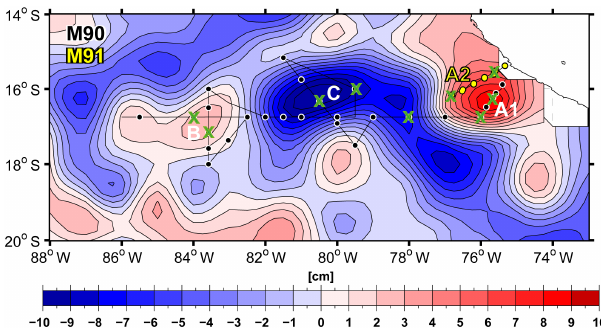
Figure 1. Distribution of AVISO satellite-derived sea surface height anomaly (SSHA) distribution as described by Stramma et al. (2013) on 21 November 2012. Eddies are labeled in white (A and B denote the coastal and the open-ocean mode water eddies, respectively; C denotes the cyclonic eddy). The cruise track from the M90 cruise is shown in black, CTD-bottle stations are indicated with black dots, green crosses denote stations sampled for N 2 fixation. The cross section through the aged coastal mode water eddy during the con- secutive cruise M91 is denoted with yellow dots